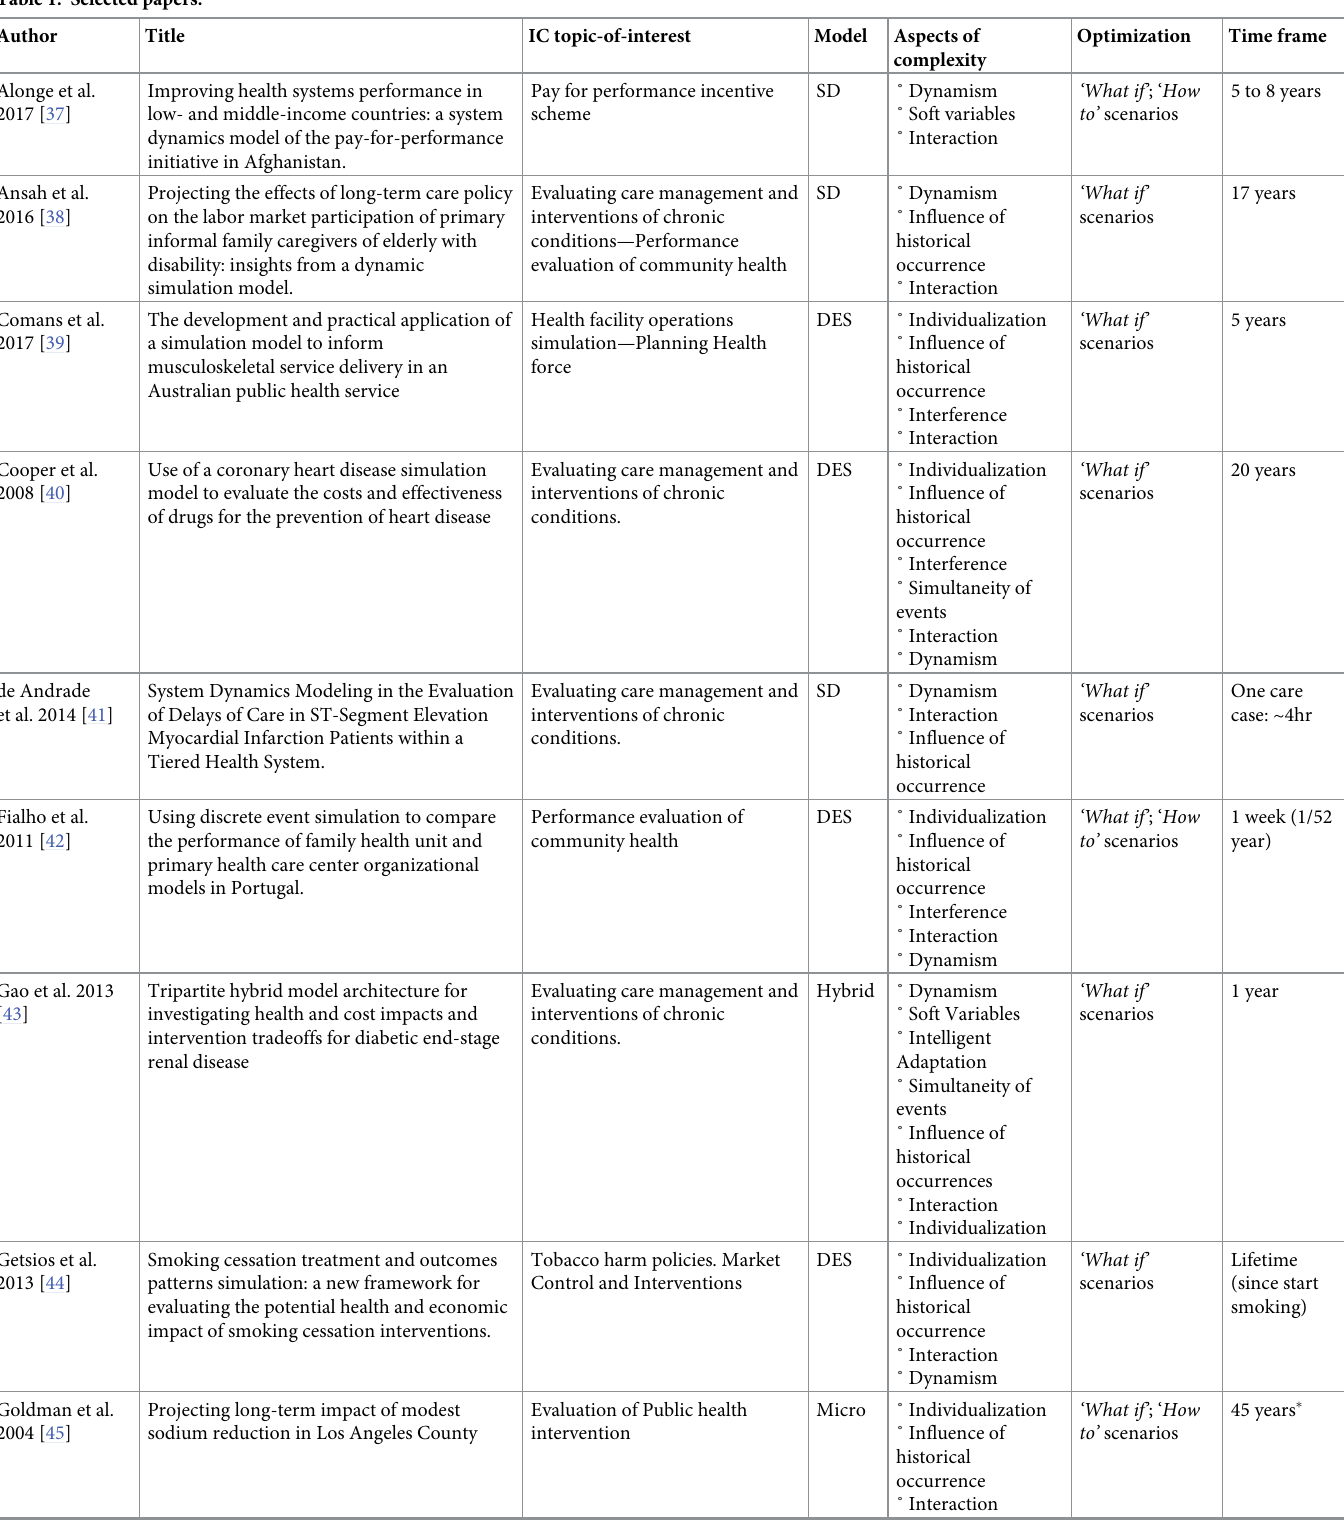
Table 1. Selected